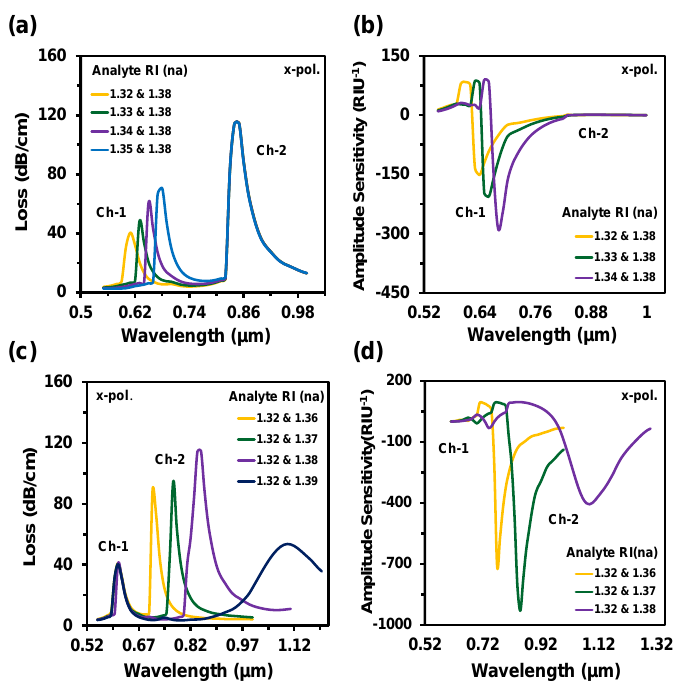
Figure 6. ( a , c ) CL spectra and ( b , d ) amplitude sensitivity of the proposed sensor when the analyte RIs of Ch-1 varies with constant Ch-2 and Ch-2 varies with fixed Ch-1, respectively. Figure 7a,b depict the CL and AS spectra when both channels used the same analyte RIs. This alteration happened from RI 1.32 to 1.39. In this variation, the sensor exhibited a maximum WS of 20,000 nm/RIU and an AS of 760 RIU −1 with an SR of 5 × 10 −6 RIU −1 . In this case, the LOD was 3.05 × 10 −6 RIU 2 /nm. Figure 7c represents the 2D map of CL inten- sity where minimum intensity was observed at RI 1.32 and the maximum intensity was observed at RI 1.39. Sensor length is very important to determine the feasibility of any sensor, which is illustrated in Figure 8a. This parameter is inversely proportional to the